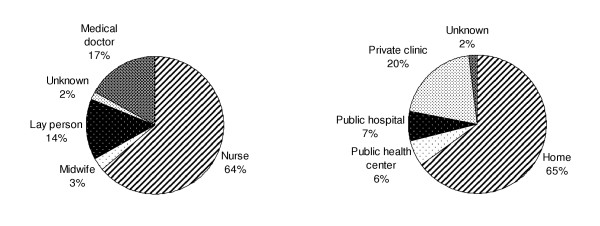
Distribution of injections by provider type and setting*, Takeo Province, Cambodia, 2002 (n = 96) *Data refer to the most recent injection received by adults reporting ≥ 1 injection in the previous 6 months